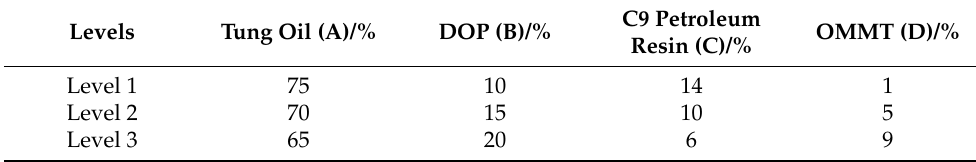
Table 3. Factor levels of orthogonal test design.